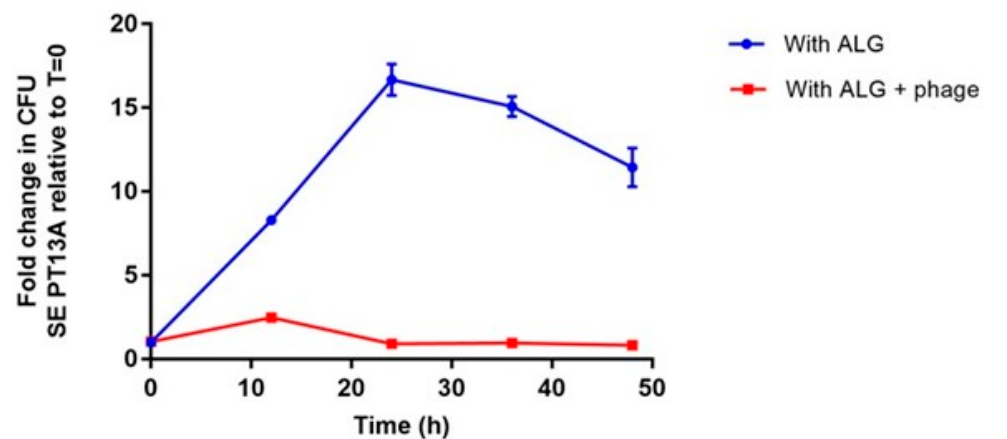
Figure 5. In vitro assay showing the relative influence of ALG and ALG + phage beads on the growth of Salmonella Enteritidis PT13A over 48 h.